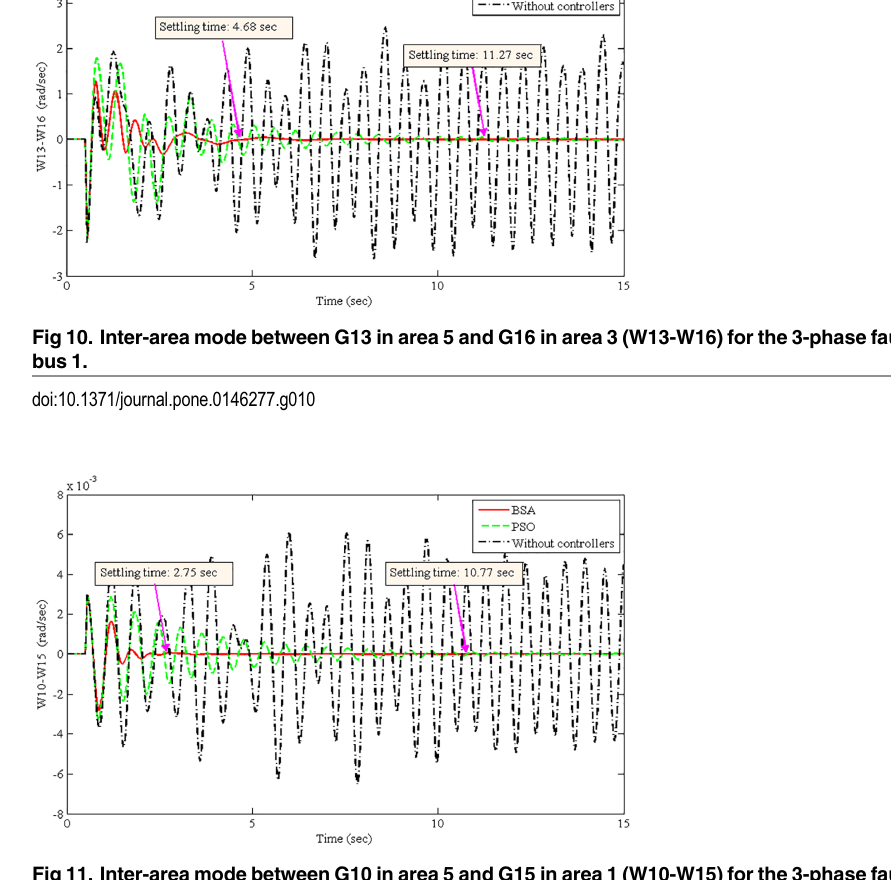
Fig 11. Inter-area mode between G10 in area 5 and G15 in area 1 (W10-W15) for the 3-phase fault at bus 1.